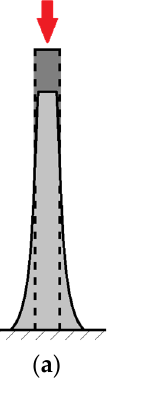
Figure 1. Wall failure by ( a ) plastic collapse and ( b ) elastic buckling [26].